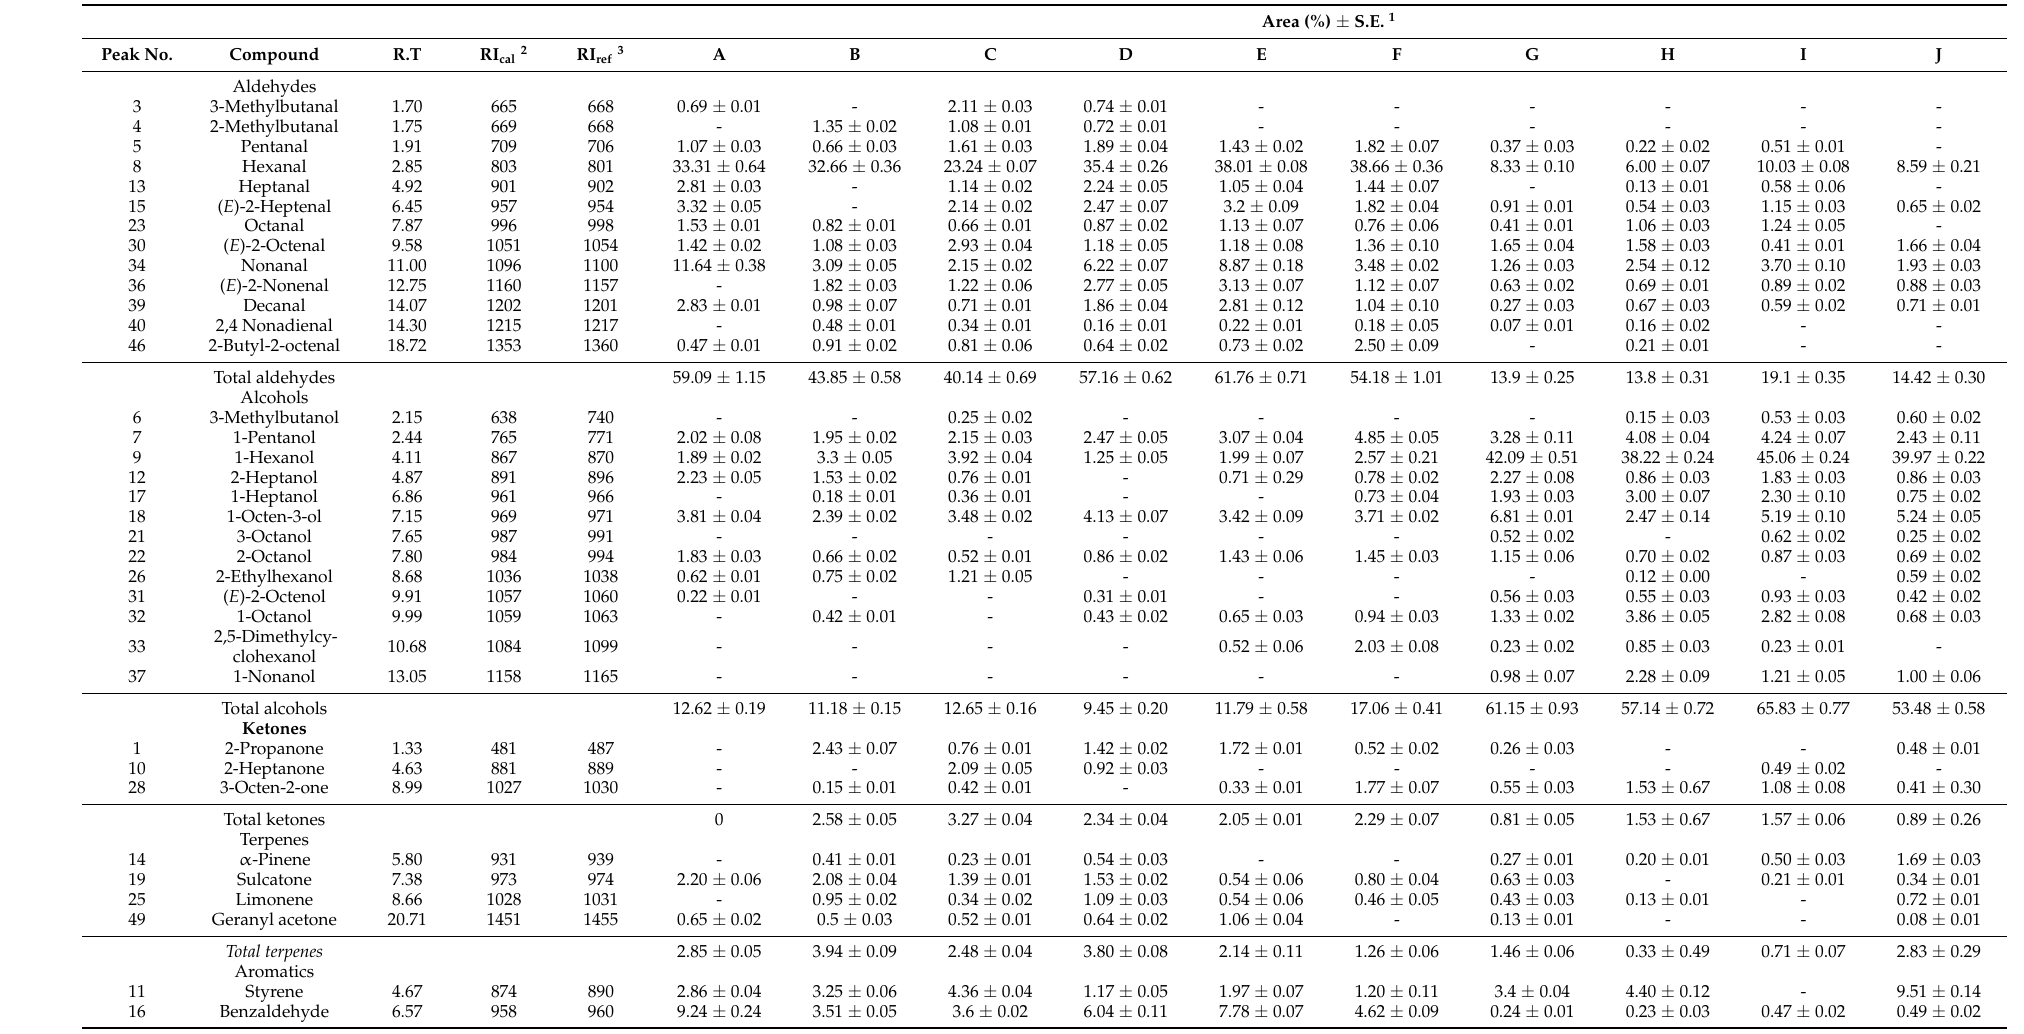
Table 4. VOCs levels detected in the head-space of different cereal and legume pasta